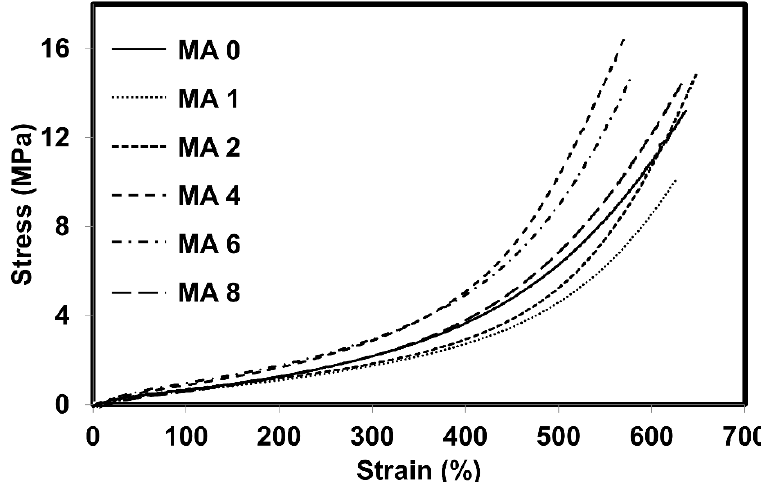
Figure 4. Stress–strain curves of the NR/HNT and MNR/HNT composites.